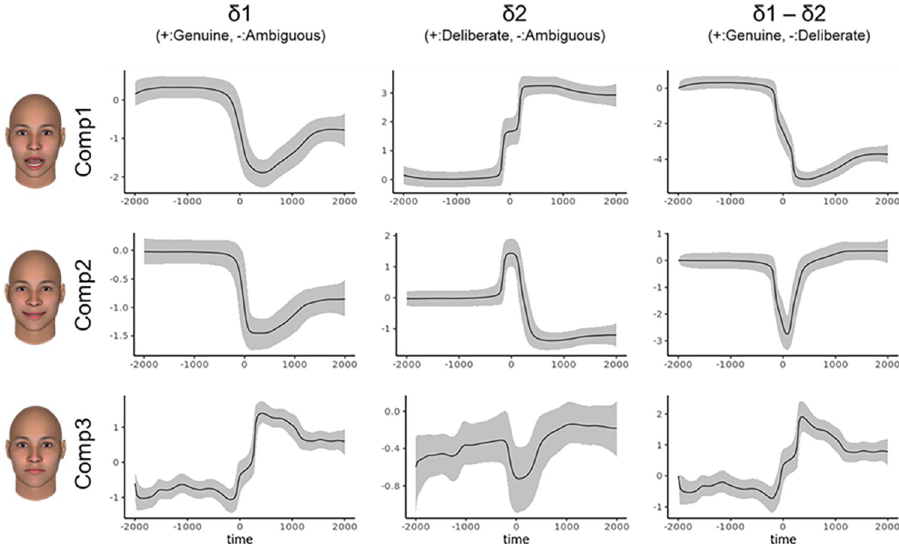
Fig 3. Time-series patterns for the magnitude of difference between the perceived-as-genuine and perceived-as- deliberate expressions of happiness. The y-axis represents the extent of the “ δ ” parameters for each component. Solid lines indicate the expected a posteriori. Positive values refer to a relatively large spatial component of (left: perceived- as-genuine, center: deliberate, right: genuine), while negative values indicate a relatively large spatial component of (left and center: perceived-as-ambiguous, right: deliberate). The ribbons represent 99% credible intervals.